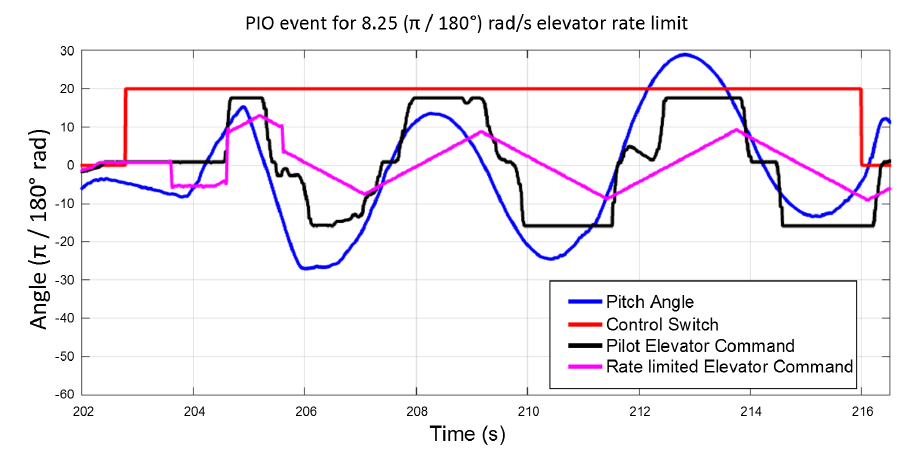
Figure 4. PIO event following 8.25 ◦ /s elevator actuator rate